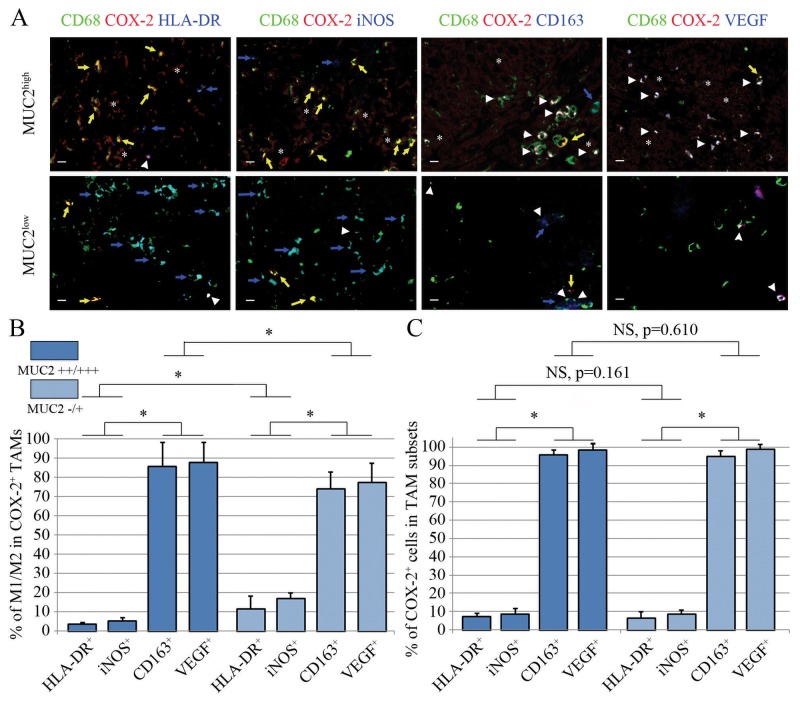
M1 and M2 distribution patterns of the COX-2+ TAMs in the high and low MUC2 expression groups.(A) Representative CD68, COX-2 and M1/M2 signature triple-immunostained sections are shown. Arrowhead, COX-2+ TAMs that expressed the M1 or M2 signatures. Yellow arrow, COX-2+ TAMs that did not express the M1 or M2 signature indices. Blue arrow, COX-2- M1 or M2 TAMs. Asterisk, COX-2+ cancer cells. Scale bar, 10 μm. (B) The percentages of M1- and M2-polarized TAMs in the CD68+COX-2+ TAM populations that infiltrated the cancer tissue in the two MUC2 expression-level groups were compared. (C) The percentages of COX-2+ cells in the M1 and M2 populations of the intratumoral TAMs in the two MUC2 expression-level groups were compared. It could be noted that most of the COX-2+ TAMs in both the high and low MUC2 expression groups exhibited M2 signatures (i.e., CD163+ and VEGF+). *, p<0.05, ANOVA. NS, no significance, ANOVA.